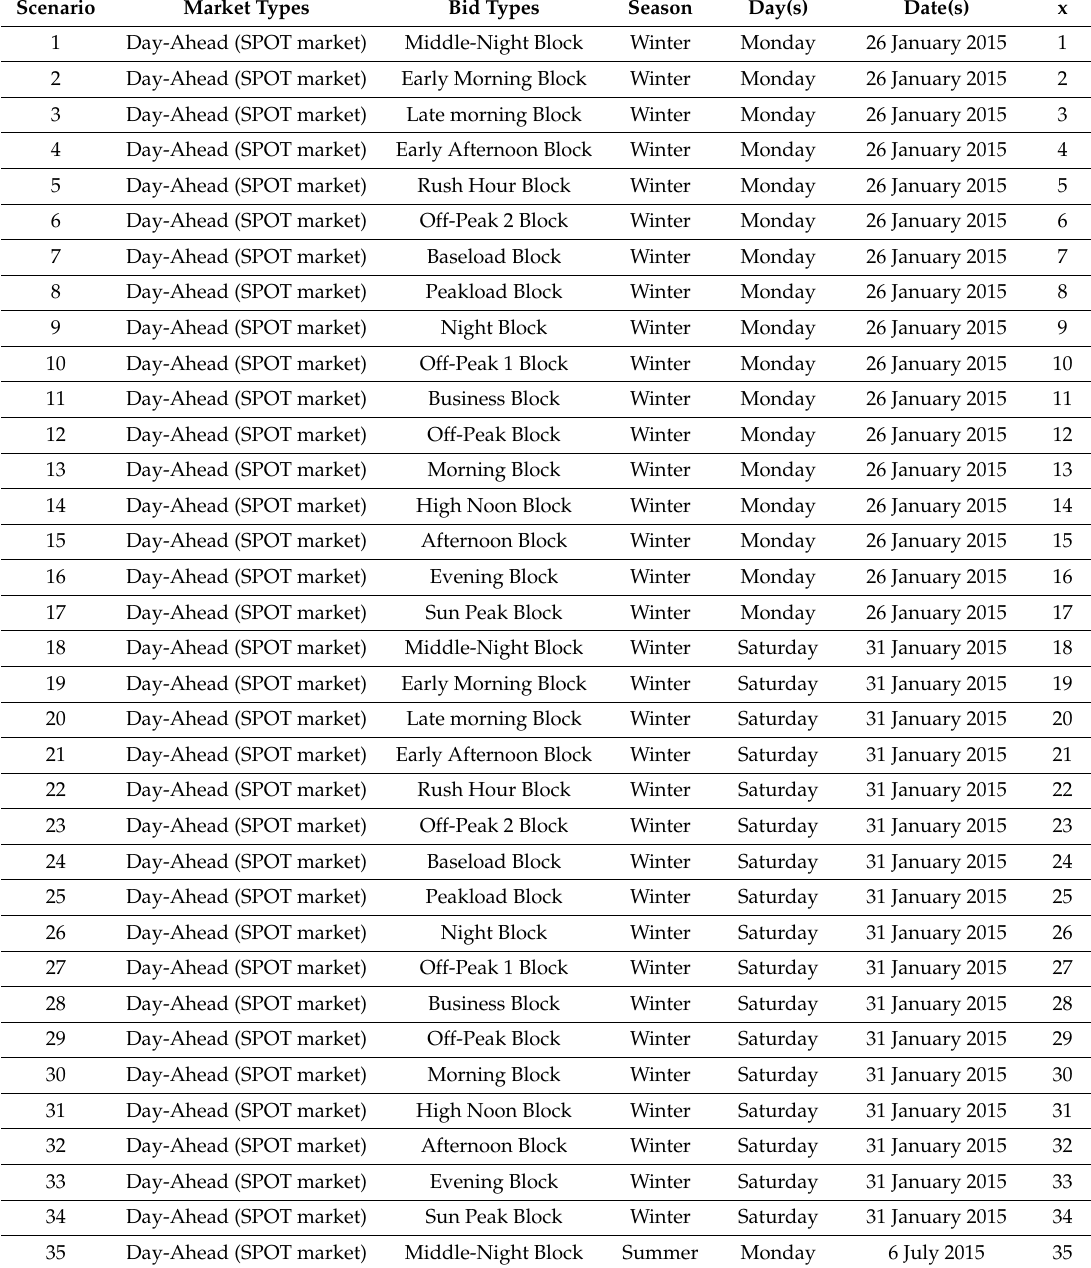
Table A1. All market products of each VPP